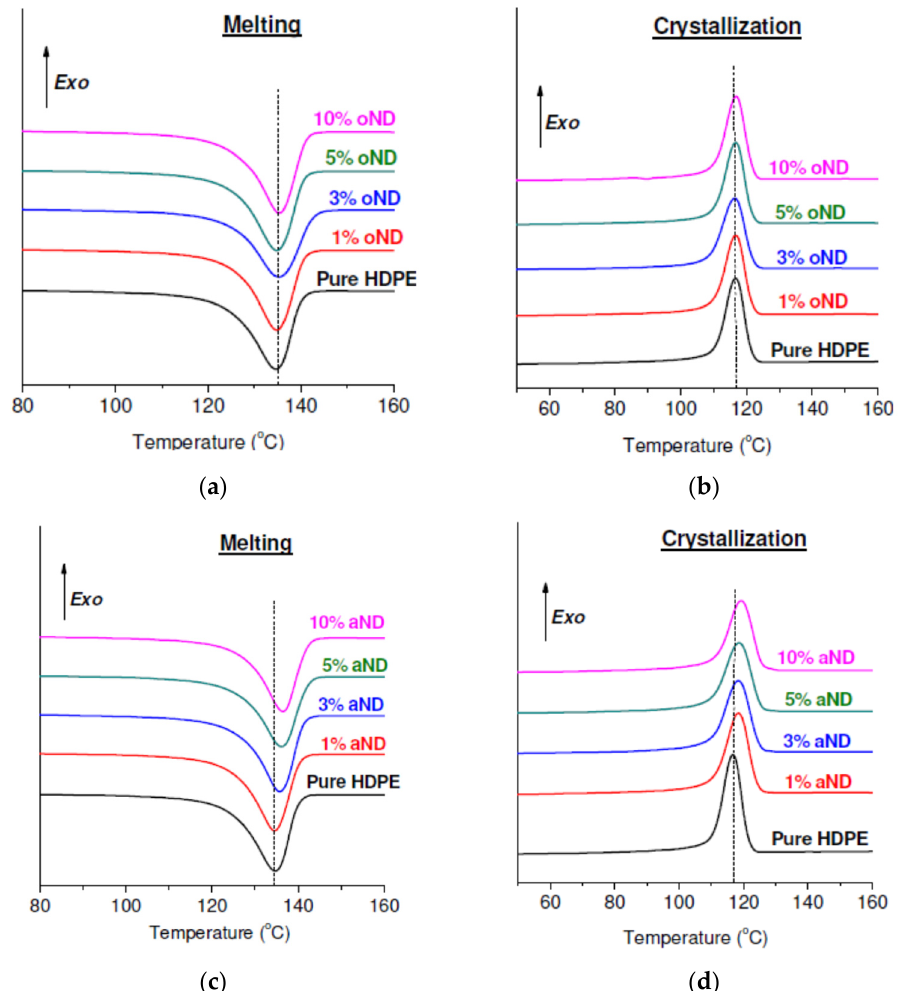
Figure 1. Thermograms of melting (left) and crystallization (right) processes of the unoriented fibers with the addition of oND ( a , b ) and aND ( c , d )